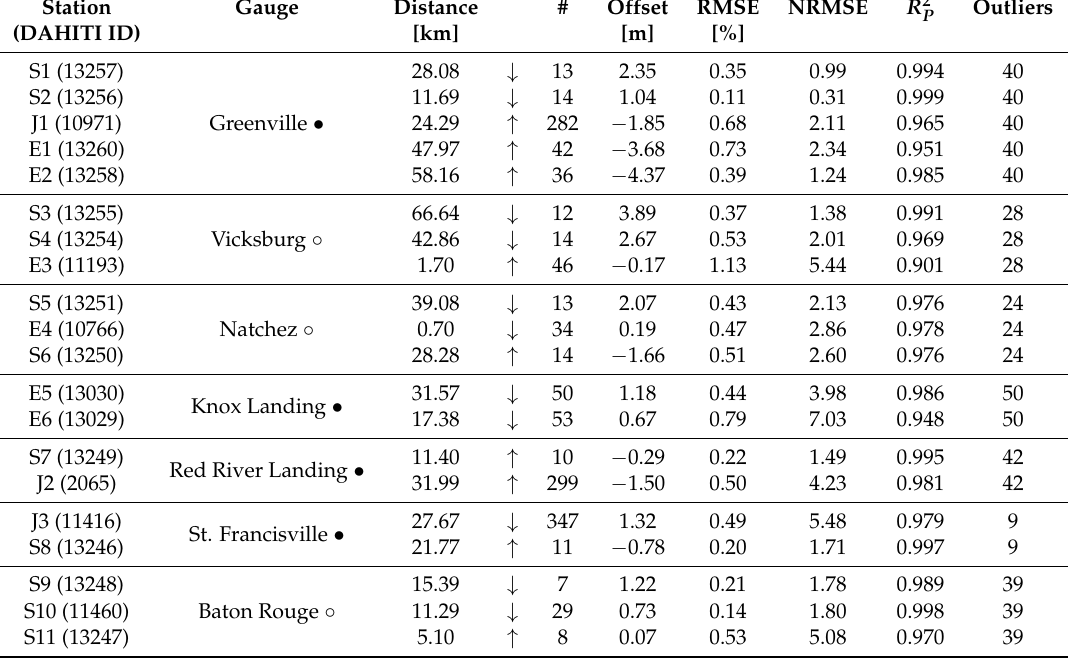
Table 1. Satellite altimetry comparison with in situ gauges showing the distance between the two locations, the number # of synchronous observations and the respective median offset, RMSE, NRMSE and the squared Pearson correlation coefficient R 2 . The arrows indicate whether the stage ( • ) or P combined stage and discharge ( ◦ ) gauge is located upstream ( ↑ ) or downstream ( ↓ ) of the virtual station.